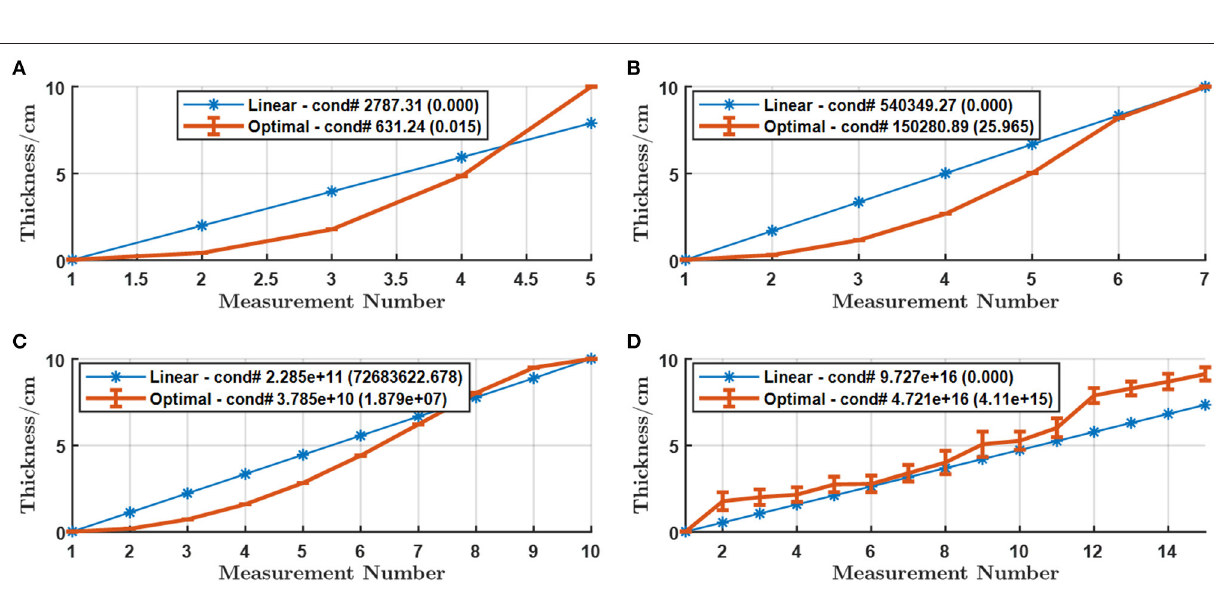
FIGURE 4 | Optimal thickness arrangement against the best linear arrangement for (A) M within [0.02, 10] cm. The error-bars in the curve stand for the standard deviations of the thickness while the number in parentheses in the legend is the standard deviation of the condition number for 30